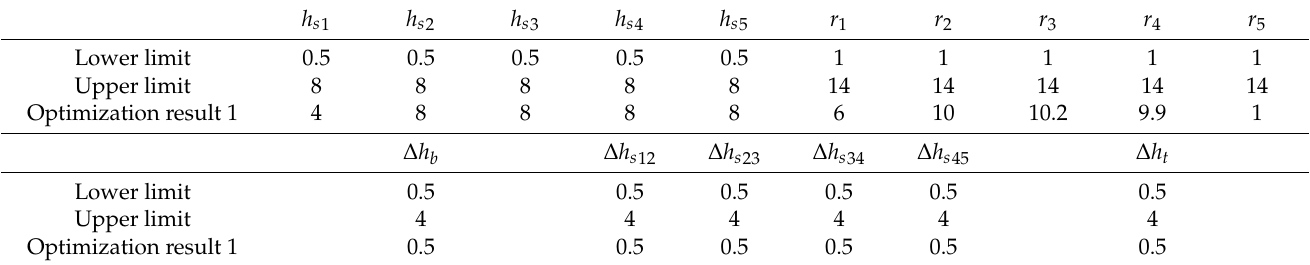
Table 2. Model optimization